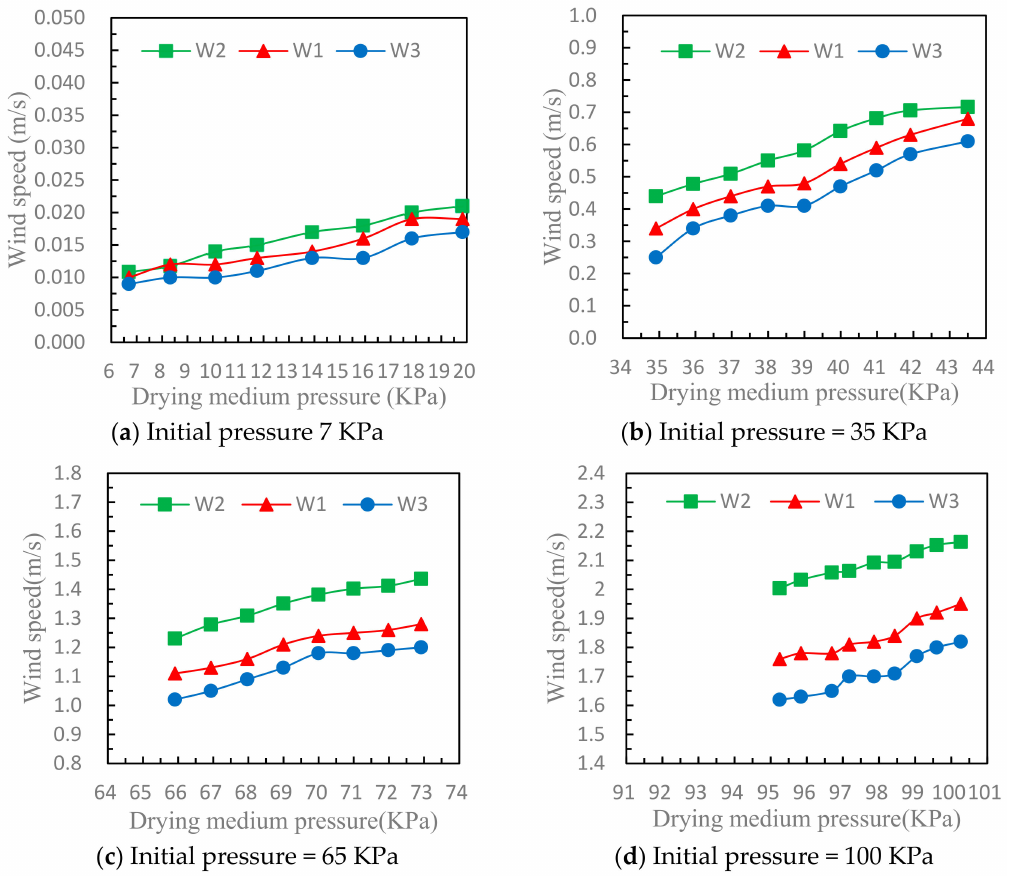
Figure 6. Variation in wind speed during drying under different initial